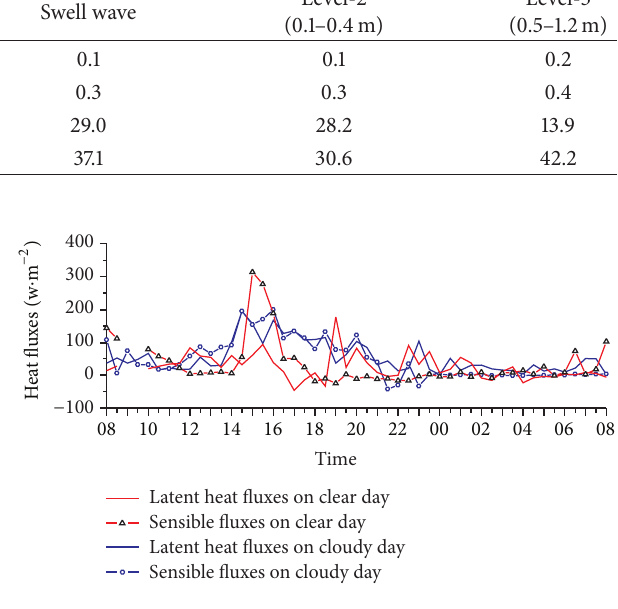
Figure 6: Diurnal variations in sensible and latent heat fluxes on clear and cloudy